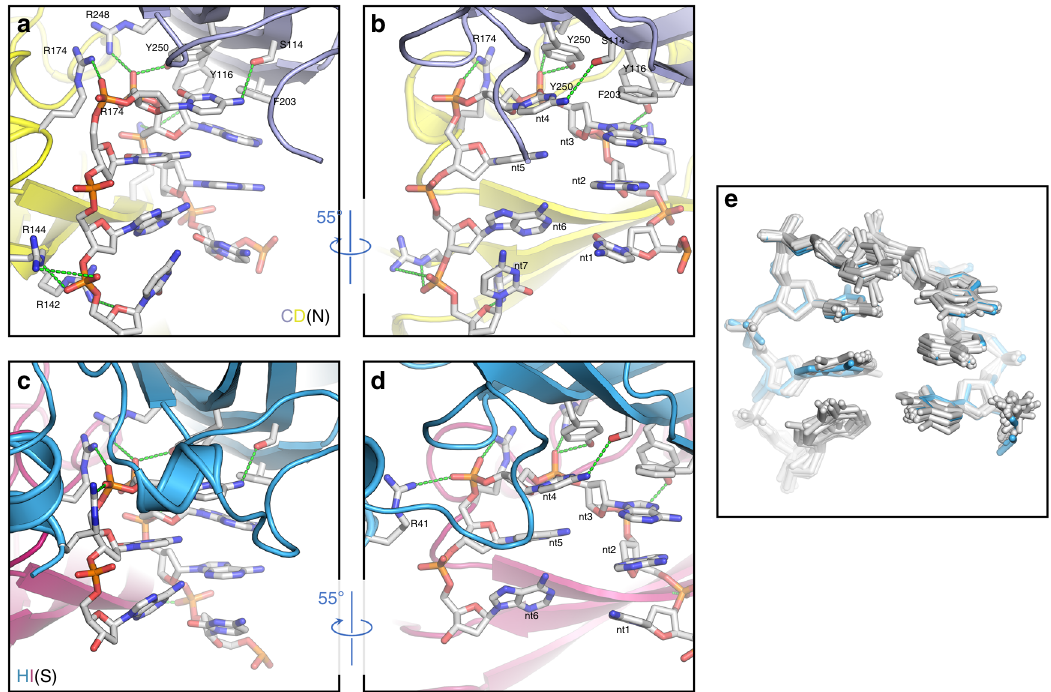
Fig. 5 Details of interactions between DNA and CP. The details of the interactions between CP subunits and bound DNA. a The atomic model of “ CD-type ” DNA (i.e. DNA:CP interactions in the majority of the capsid (CPs A-G & I-K)) and the neighboring CPs (C and D). b as in a rotated 55 degrees as indicated. a , b show the interactions between polar sidechains and both the DNA bases and backbone at positions 2, 3, and 4, along with a base stacking interaction between F203 and the base of nucleotide 4. c , d The atomic model of “ HI-type ” DNA (i.e. DNA:CP interactions at the interface) and the neighboring CPs (H and I). At the interface, we see an extra interaction formed from the extreme N-terminus of the ordered density (residue 41) and the fi fth nucleotide in the stem loop, which appears to stabilize the ordered N-terminal helix-loop-helix domain ( c , d ). e The overall conformation of the DNA stem-loop in each position is essentially identical. In e all chains are colored gray, except for H